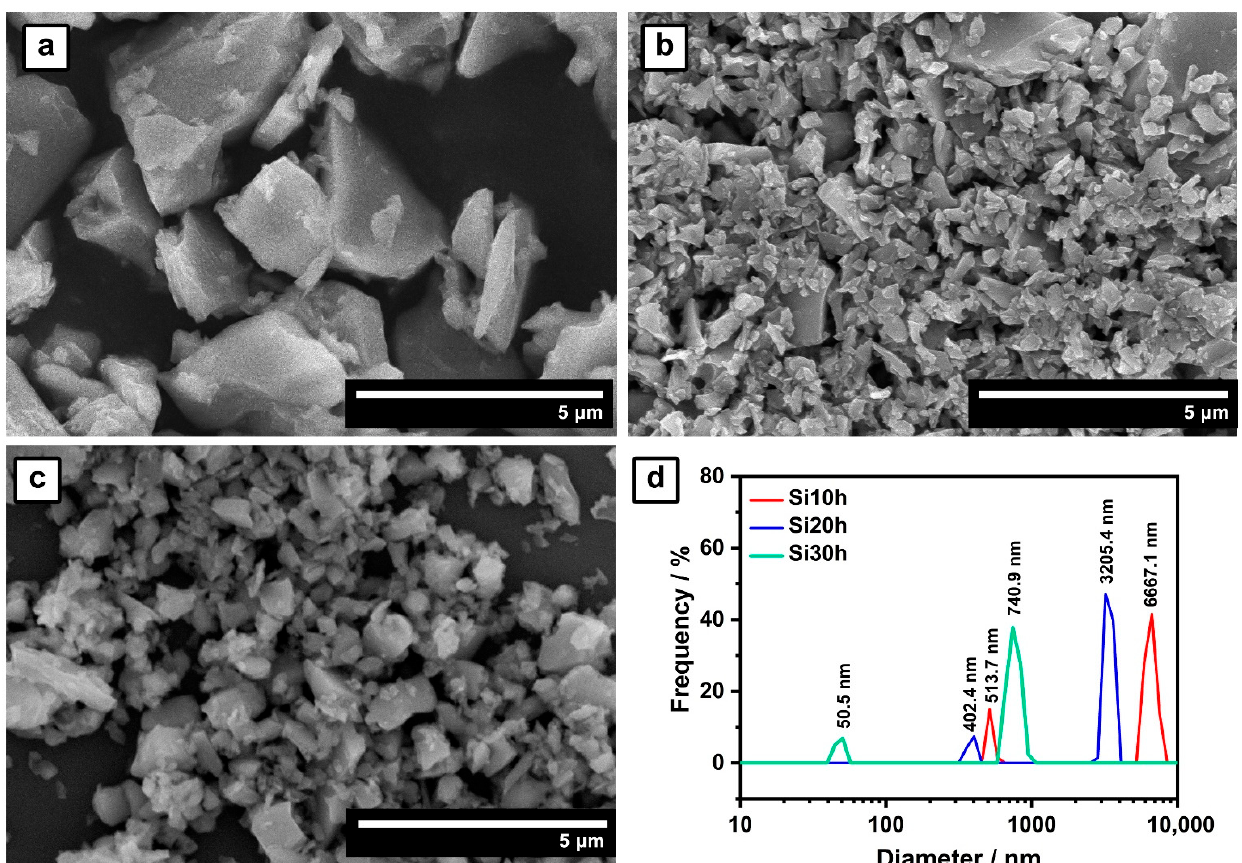
Figure 1. SEM images of silicon particles resulting from the ball-milling process for ( a ) 10 h (Si10h), ( b ) 20 h (Si20h), and ( c ) 30 h (Si30h). ( d ) Particle size distribution of Si10h, Si20h, and Si30h.